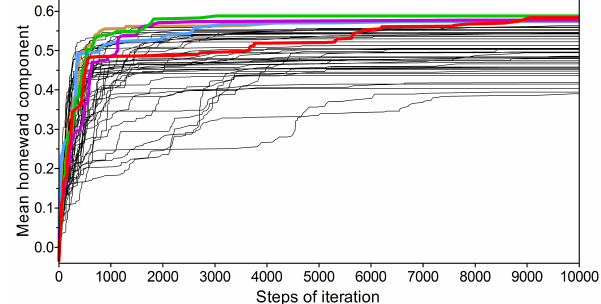
Fig. 1. Improvement of overall homeward components c H in the course of 50 consecutive ItRuns (single lines), each consisting of 10 4 ItSteps . The five ItRuns ending up with the highest values are highlighted by coloured lines. Included are 64 sites 90–200km from the